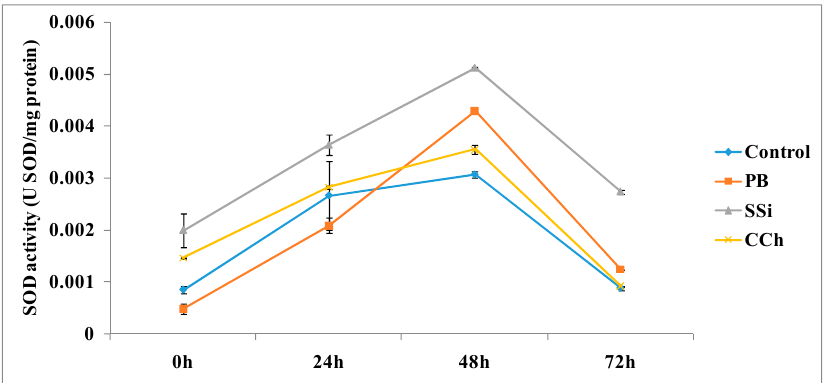
Figure 3. Time course of SOD activity (U SOD/mg protein) in extracts from table grape cv. Italia peel treated or not with PB, SSi and CCh. All the values are the means of three replicates ± SE.